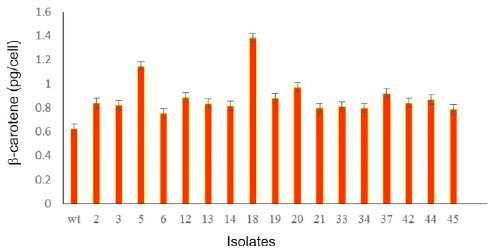
Fig. 5. Bar diagram represents β -carotene content (pg/ cell) of 17 selected survival mutants grown in modified Johnson’s medium under light intensity 200 mmol photons m -2 ·s -1 at 12 th day of cultivation